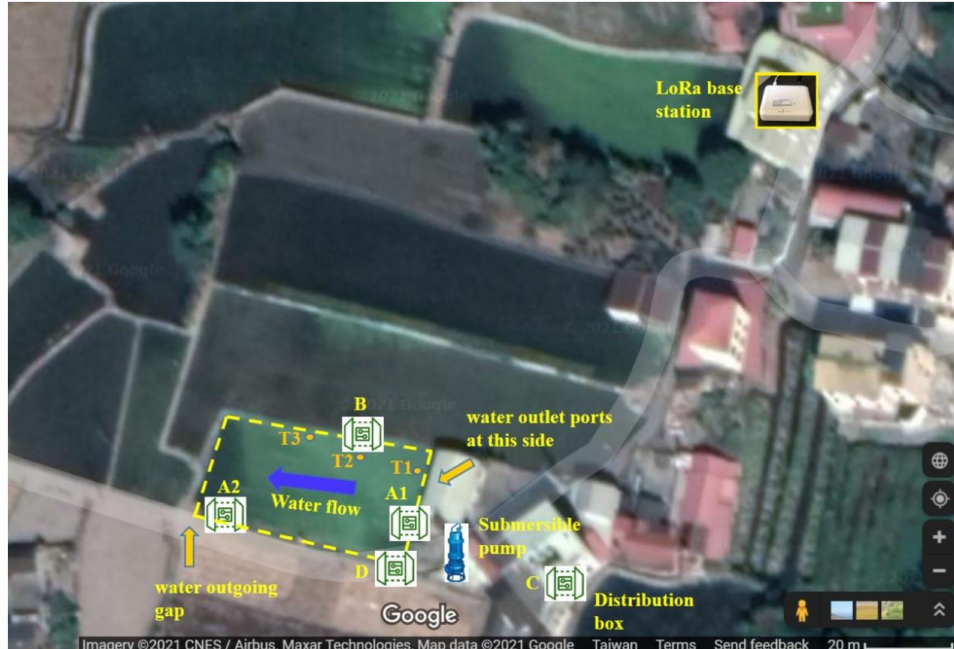
Figure 7. Field deployment